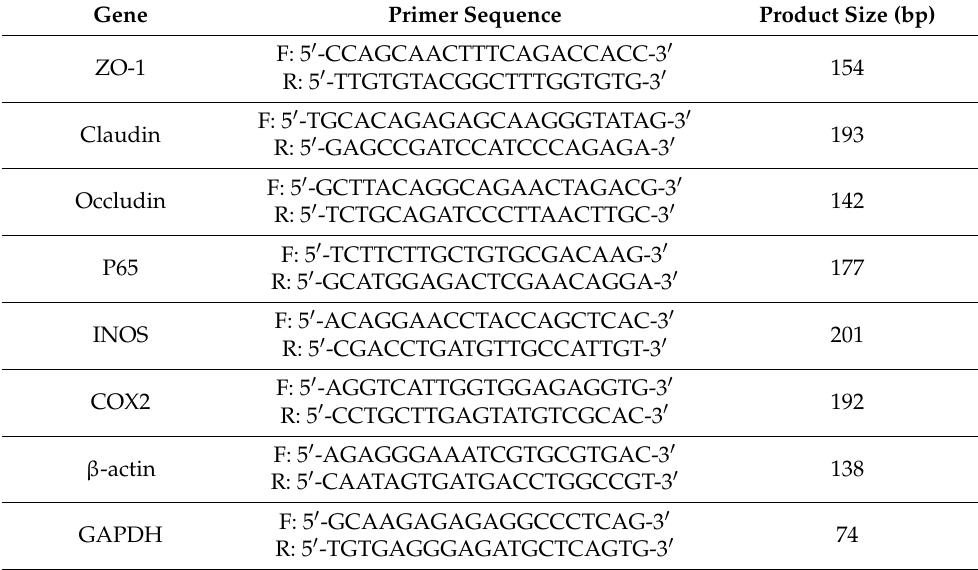
Table 1. Real-time PCR primer sequences used in the